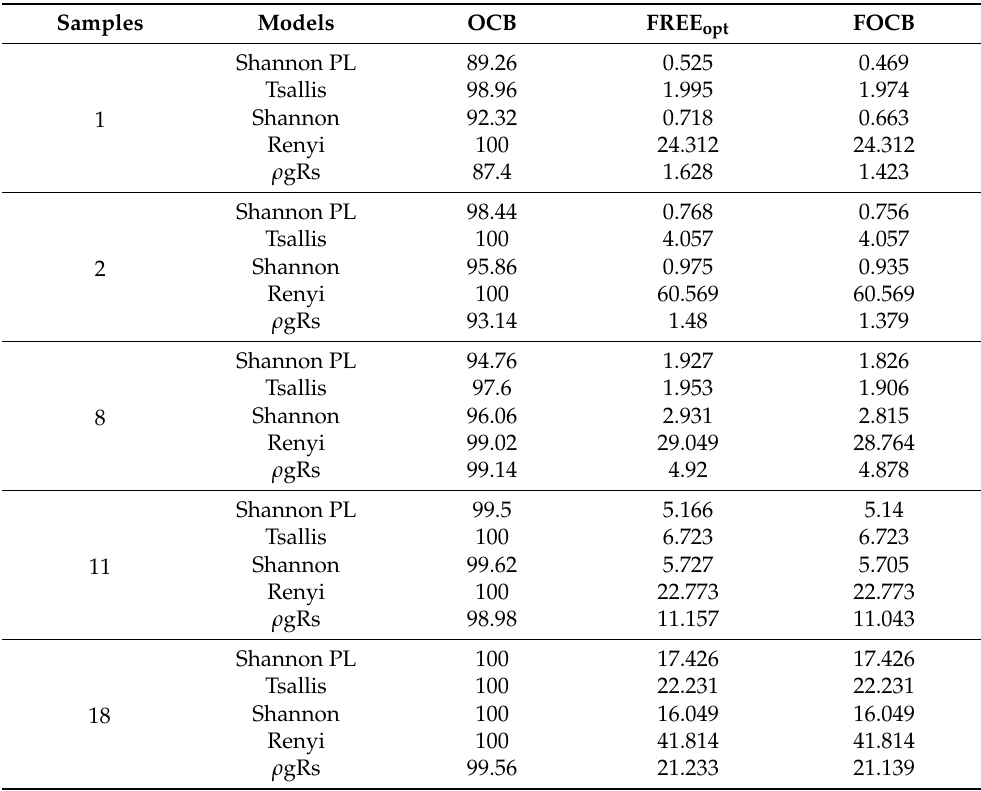
Table 3. Statistical indexes based on HBMES-2 uncertainty method for four entropy models for shear stress